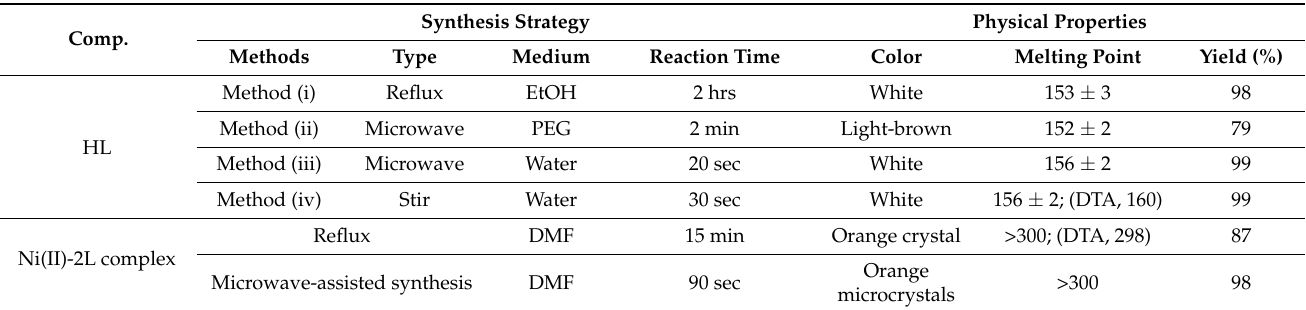
Table 2. Physical properties of the synthesized N (cid:48) -(4-methoxybenzylidene)benzohydrazide Schiff (HL) base and its nickel(II) complex (Ni(II)-2L). Comp.